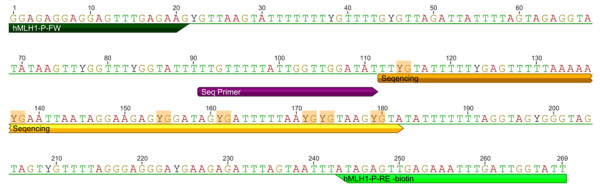
MLH1 Region 1 sequenceand primers. MLH1 region 1: Bisulfite-converted MLH1 promoter 5′-3′sequence and primers used for pyrosequencing. Analyzed CpGs within the sequenced area are shaded orange.